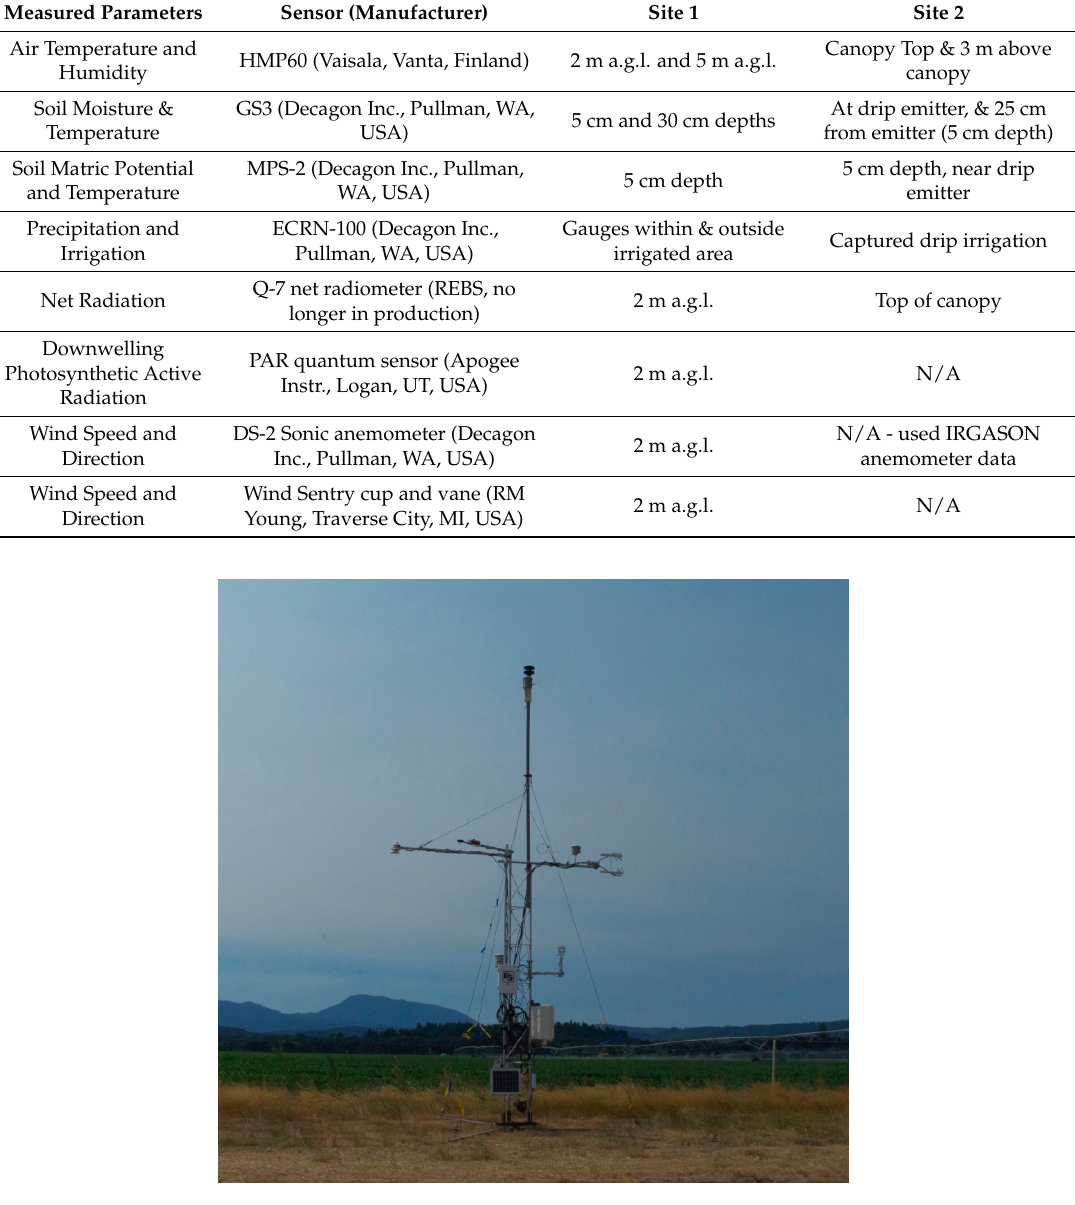
Figure 1. Typical sensor array used in the field experiments shown at site 1. Crop (green beans) and center pivot irrigation system is visible in the background. Note that this is not the full array used for the 8-month period at site 1 but an auxiliary system that is shown for clarity. The eddy-covariance system used here (IRGASON) is visible extending to the right.